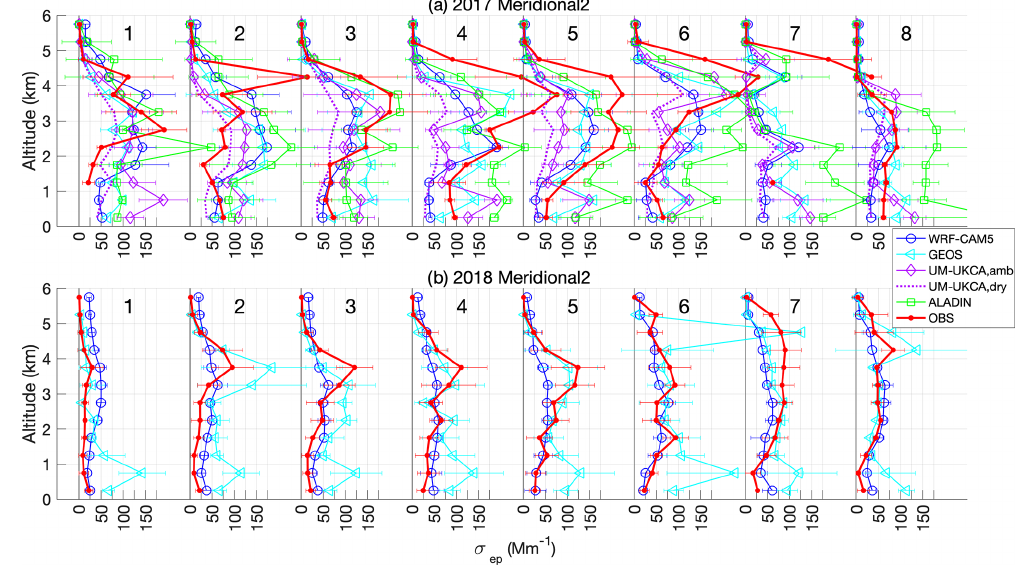
Figure 7. As in Fig. 4 but for the (a) 2017 and (b) 2018 meridional 2 transect.